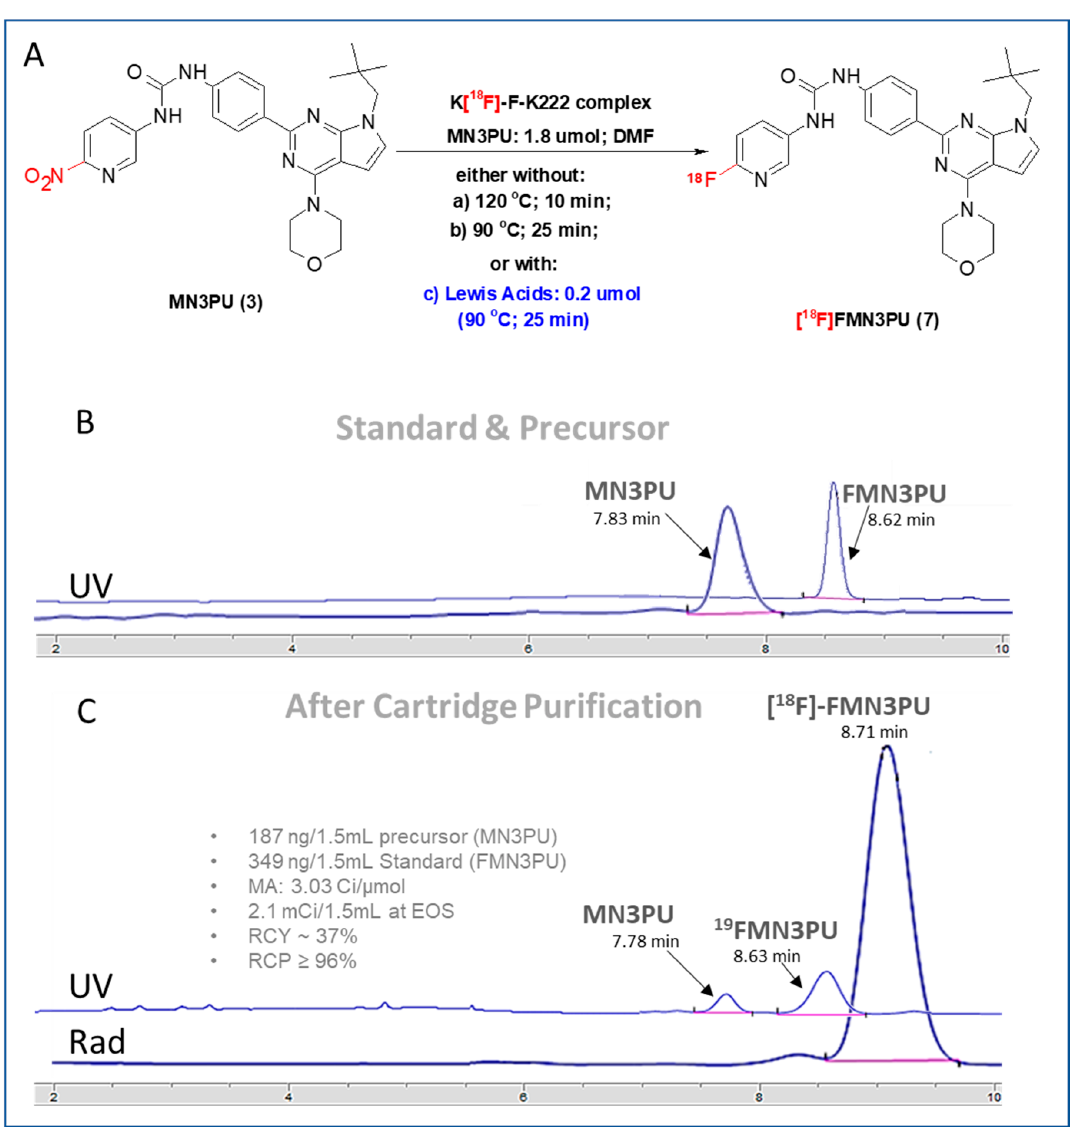
Figure 2. ( A ) Modified radiofluorination conditions of conventional methodology, either without (reaction conditions: ( a ) and ( b )), or with (reaction conditions: ( c )) Lewis acids titanocene dichloride, ferric nitrite, or chromium (II) chloride; ( B ) and ( C ) HPLC chromatograms (Standard and precursor (top B); QC (bottom, C); isocratic) for experiment with titanocene dichloride: Eluent (51% ACN in water (0.1% TFA), Phenomenex Luna (250 × 4.6 mm), Flow rate (1 mL/min) for 20 min, UV (254 nm) (Total amount of carrier and prcursor: 536 ng (non-radioactive 19 FMN3PU ( 4 ) and MN3PU ( 3 )).